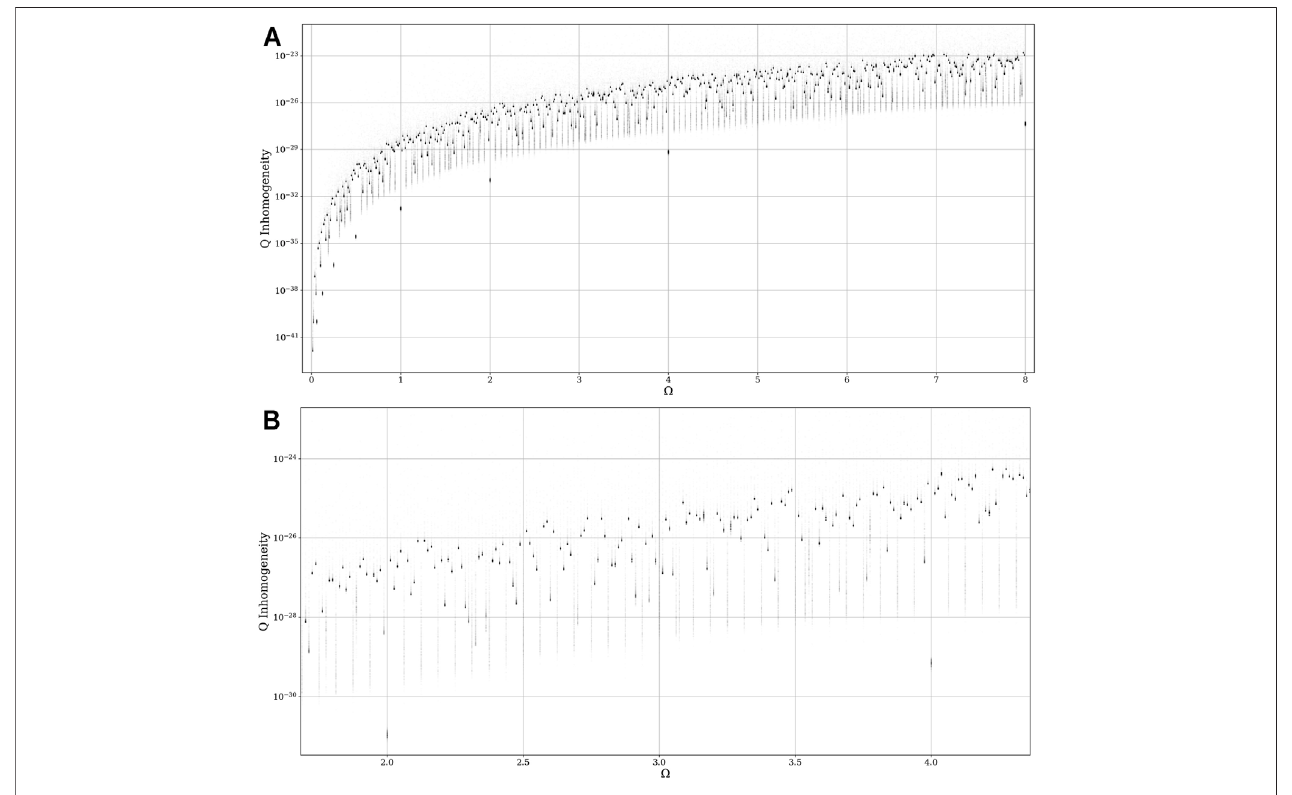
FIGURE 9 | (A) Bifurcation diagram of | Q | ′ 2 , (B) Zoomed-in bifurcation diagram of | Q | ′ 2 .